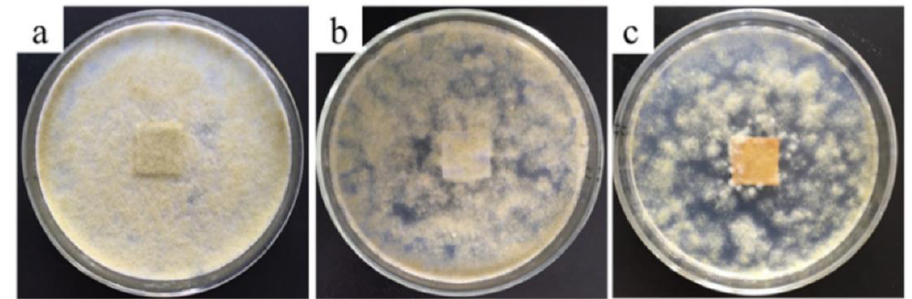
Figure 6. Antifungal activity of native cotton fabric ( a ), fabric coated with ZnO ( b ), fabric coated with Ag / ZnO ( c ). Reprinted with permission from [126]. Copyrights 2019 Elsevier.